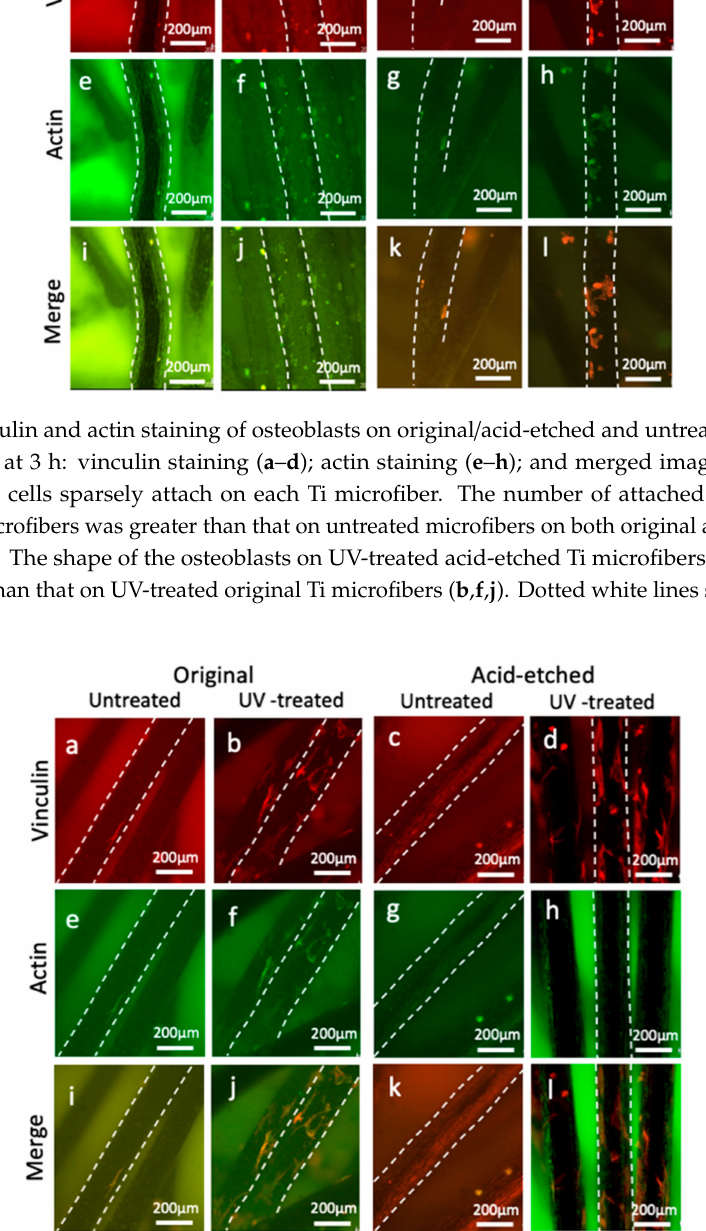
Figure 5. Vinculin and actin staining of osteoblasts on original / acid-etched and untreated- / UV-treated Ti microfibers at 24 h: vinculin staining ( a – d ); actin staining ( e – h ); and merged images ( i – l ). Small, round shaped cells sparsely attach on each Ti microfiber. The shape of the osteoblasts on UV-treated original ( b , f , j ) and acid-etched ( d , h , l ) Ti microfibers spreads with both vinculin and actin expressions on the fibers. Dotted white lines show the edges of the